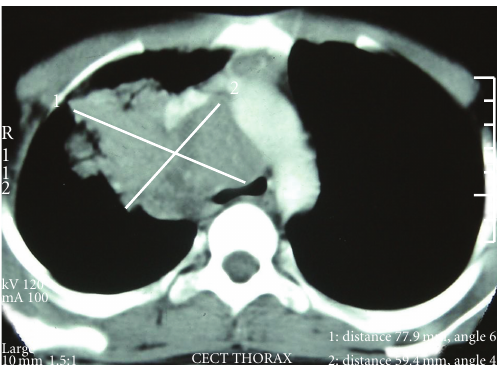
Figure 2: Photomicrograph showing epithelioid cell granulomas with necrosis (H & E stain;